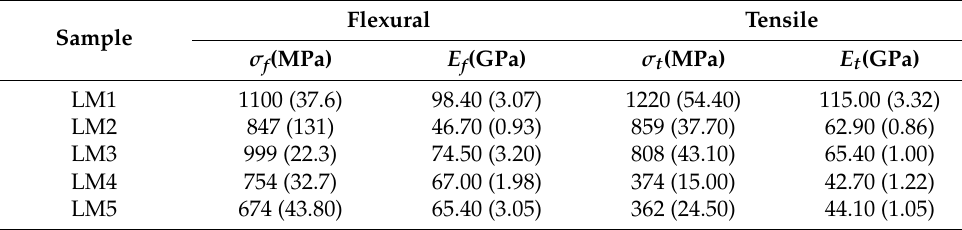
Table 3. Average flexural and tensile properties of the CFRP with different stacking sequences.